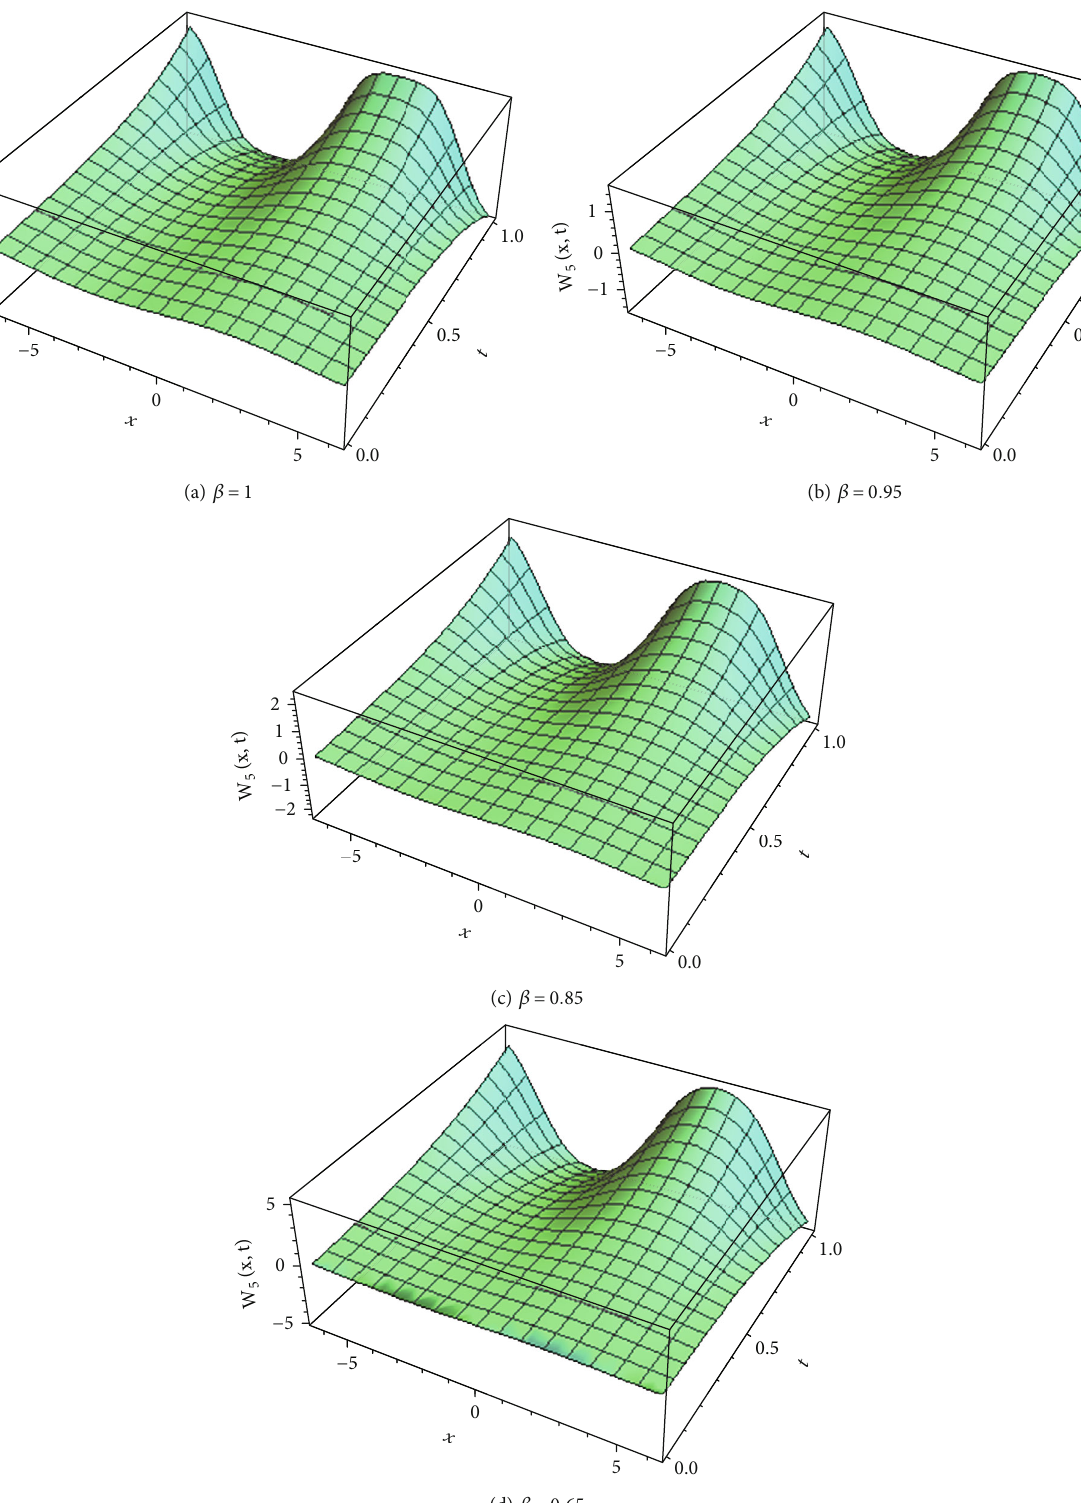
Figure 4: 3D graph representation of the 5 th -MFPS approximate solution of Example 3, for all t ∈ ½ 0, 1 (cid:2) , x ∈ ½ − 2 π , 2 π (cid:2) , L = 5 , and r = 3